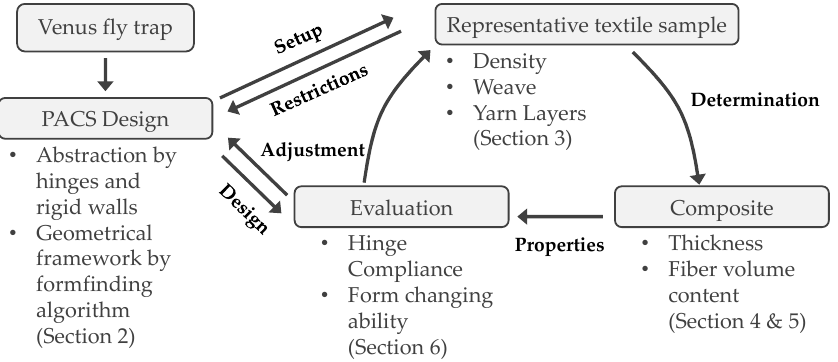
Figure 3. Process chain for the development and evaluation of textile, polymer composite, and design parameters for double-row PACS.